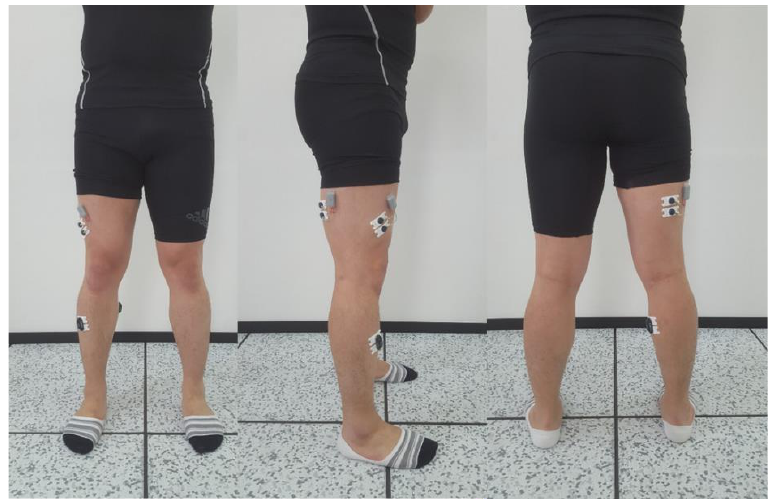
Figure 3. Attachment of EMG electrodes.